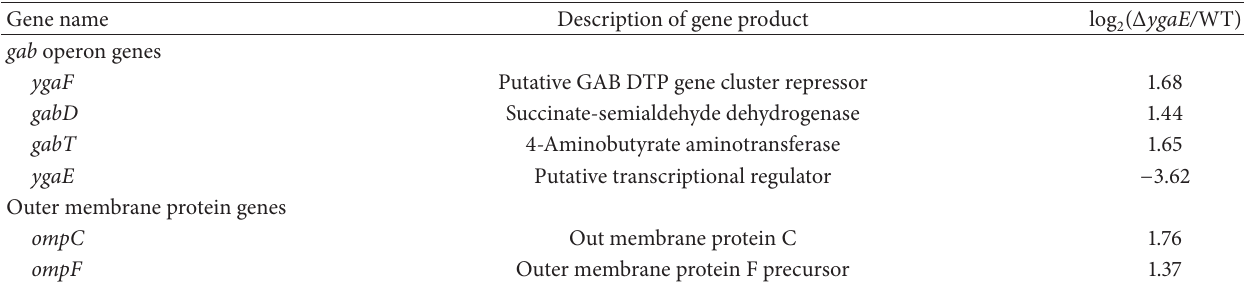
Table 3: Gene expression changes in Δ ygaE under hyperosmotic stress discussed in this